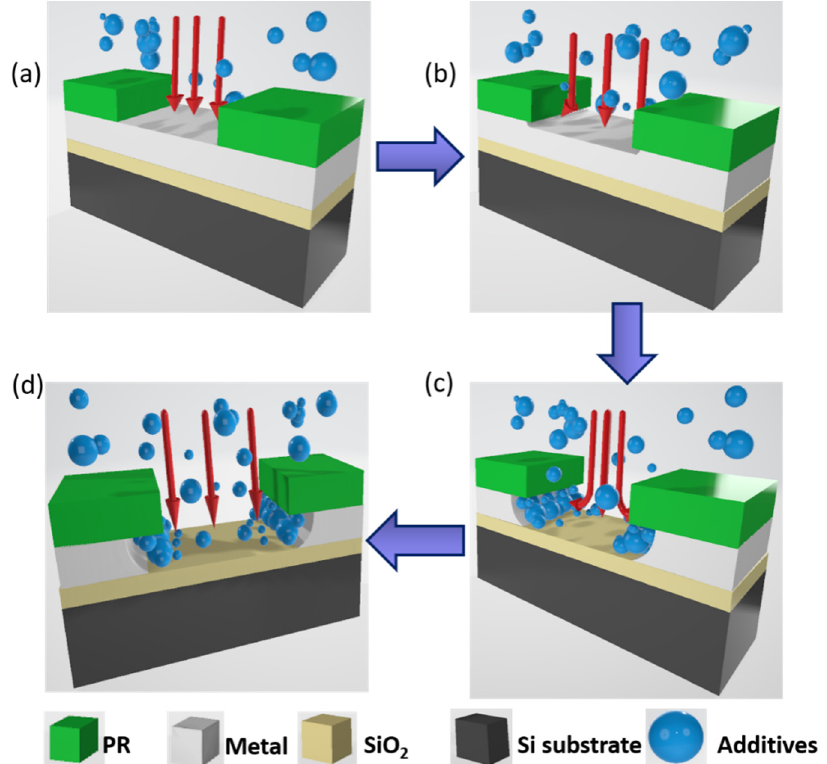
Figure 5. Schematic diagram illustrating the mechanism of macromolecular additives: ( a ) chemical reaction begins on Al surface without PR covering, ( b ) undercut appears under the photoresist, ( c ) additive particles are blocked in the narrow channel, and ( d ) additive particles in the channel limit the liquid transport and exchange.